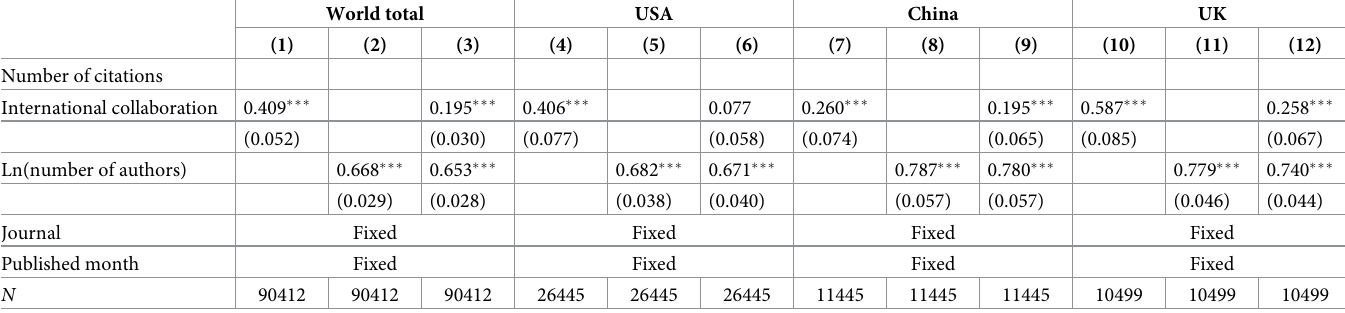
Table 6. Negative binomial regression analysis of the relationship between team structure and citation impact of coronavirus publications in